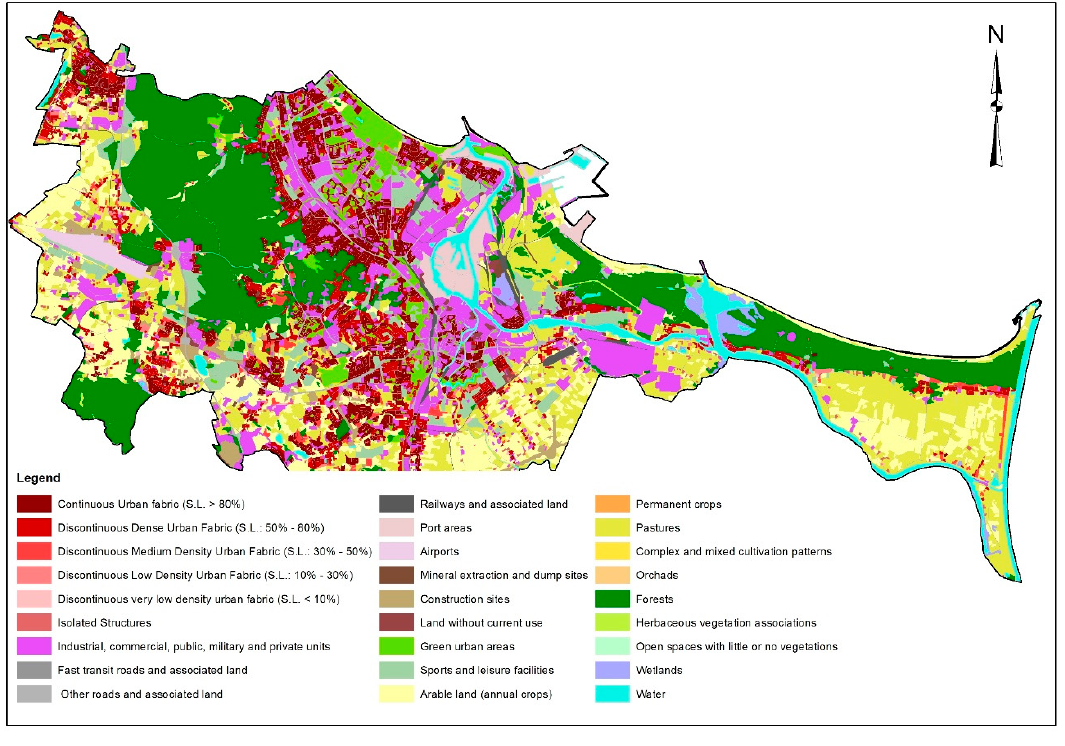
Figure 5. Land-cover of the area of Gdansk according to the Urban Atlas 2012 [27]. Table 1. Landcover in the City of GDANSK According to the Urban Atlas 2012